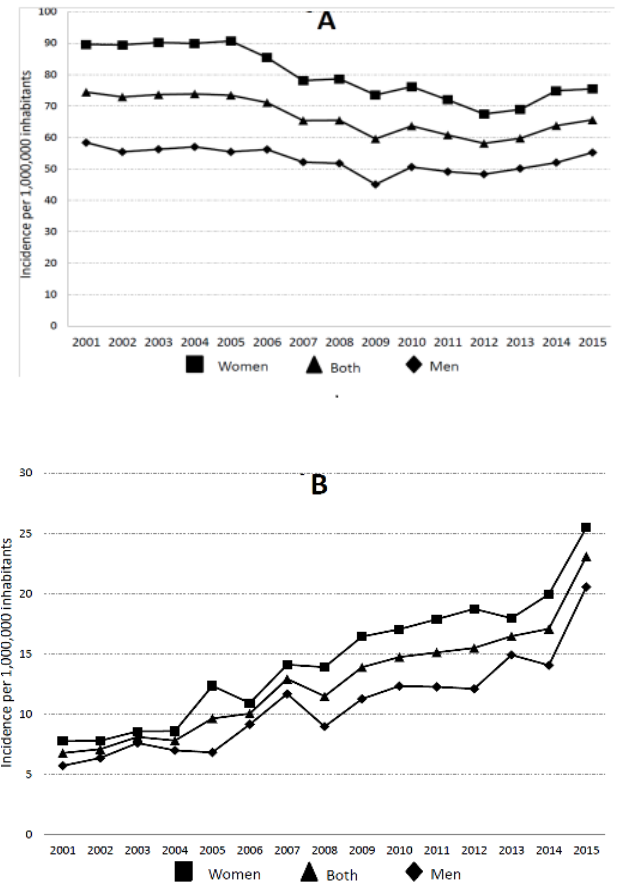
Figure 1. Trends in the hospitalization in patients undergoing mechanical ( A ) and bioprosthetic ( B ) mitral valve replacement according to sex (no. cases / 1,000,000